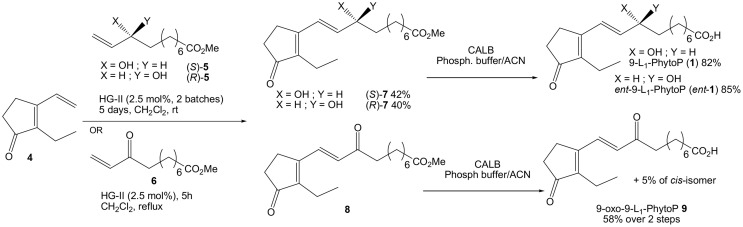
Synthesis of 9-L1-PhytoP, its enantiomer and 9-oxo-L1-PhytoP.